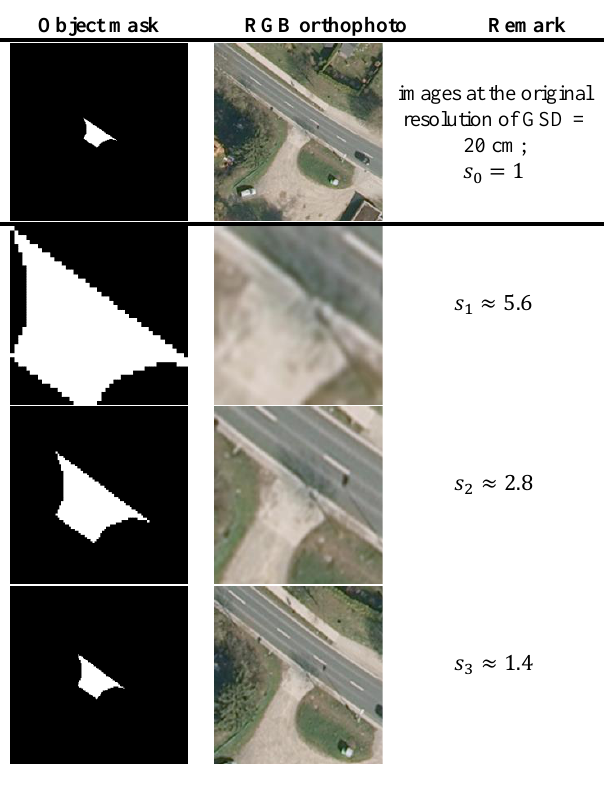
Figure 2: An example showing the contents of a small polygon at the original scale and up-scaled versions at three different scales. All images have a size of 256 x 256 pixels. The size of the polygon is about 45 x 45 pixels in the resolution of the images (about 81 m 2 in